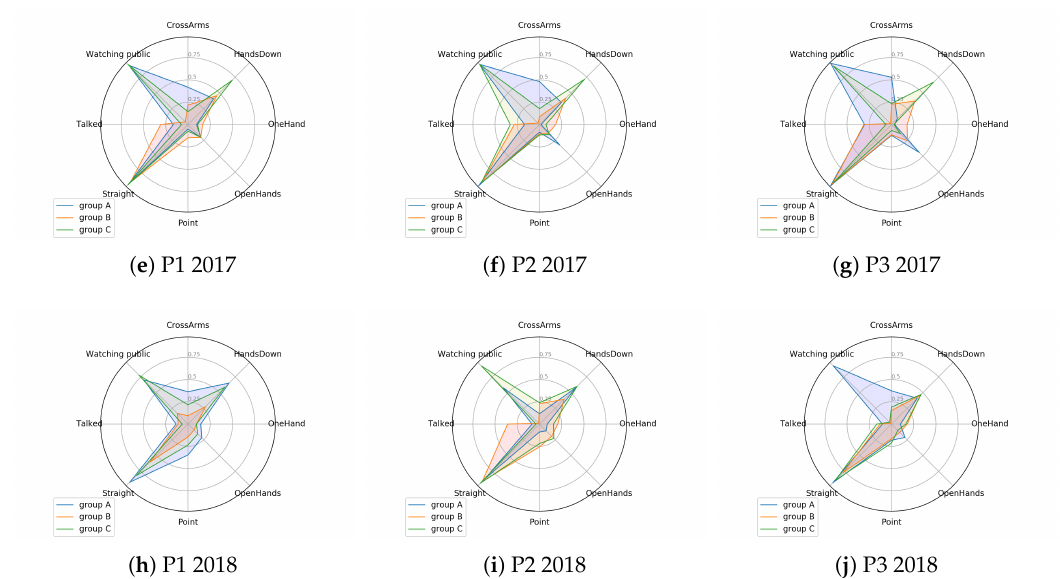
Figure 7. Polar plot of centroids’ values for each